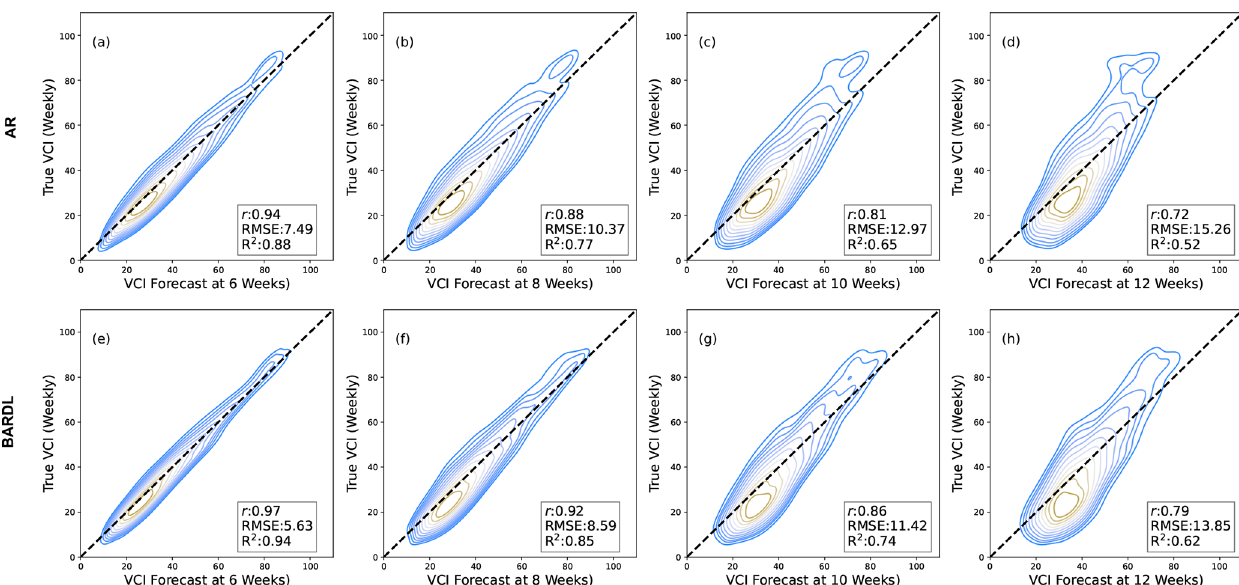
Figure 4. Contour plots showing VCI3M forecast against true VCI3M. Panels (a) – (d) show the results from the AR method with VCI3M only, and panels (e) – (h) show the overall results for BARDL modelled with lags of VCI3M plus lags of precipitation (P3M) and soil moisture (S3M) anomalies for 6-, 8-, 10-, and 12-week lead time for all counties. The contour lines (ellipses) seen in each plot indicate the various bins that make up the joint histogram plots between the forecasted and observed VCI3M values. Contour lines with a yellow shade indicate values with stronger correlation between the observed and predicted values.